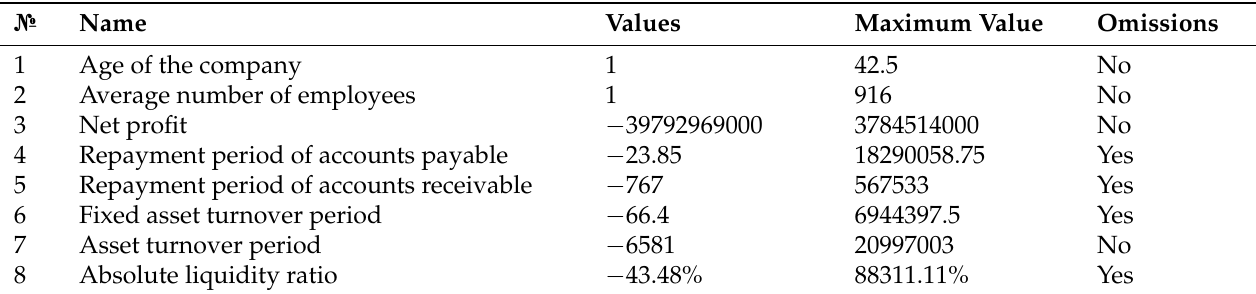
Table 4. Description of input data (Data in numeric format).